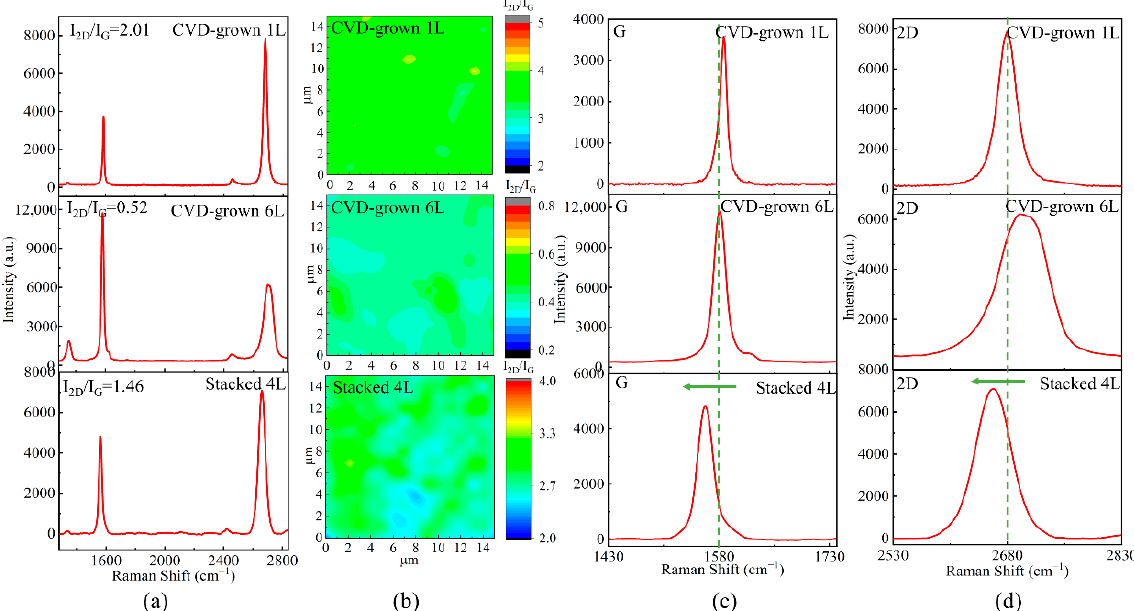
Figure 2. ( a ) Raman spectra for CVD-grown 1L, CVD-grown 6L, and stacked 4L, respectively. ( b ) Raman mapping of the ratio I 2D /I G . ( c ) Enlarged G peaks in the Raman spectra and ( d ) enlarged 2D peaks in the Raman spectra.